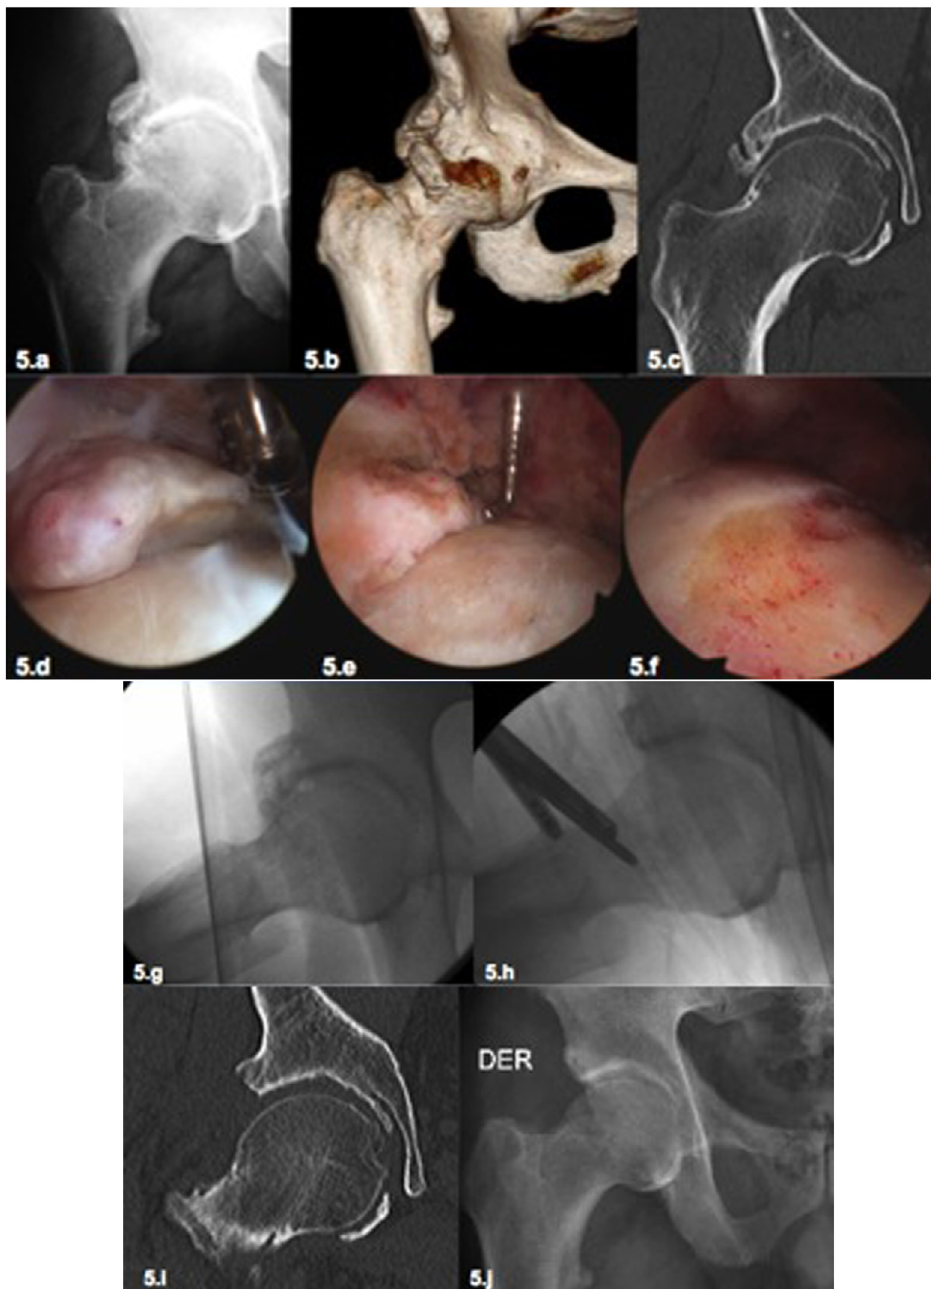
Figure 5. (5a–5f) Male patient, 65 years with an advanced osteoarthritis of the hip with a significant ROM (5a). The patient and his wife (orthopedic surgeon) refused the proposed treatment with a total joint replacement insisting to perform a hip arthroscopy. The